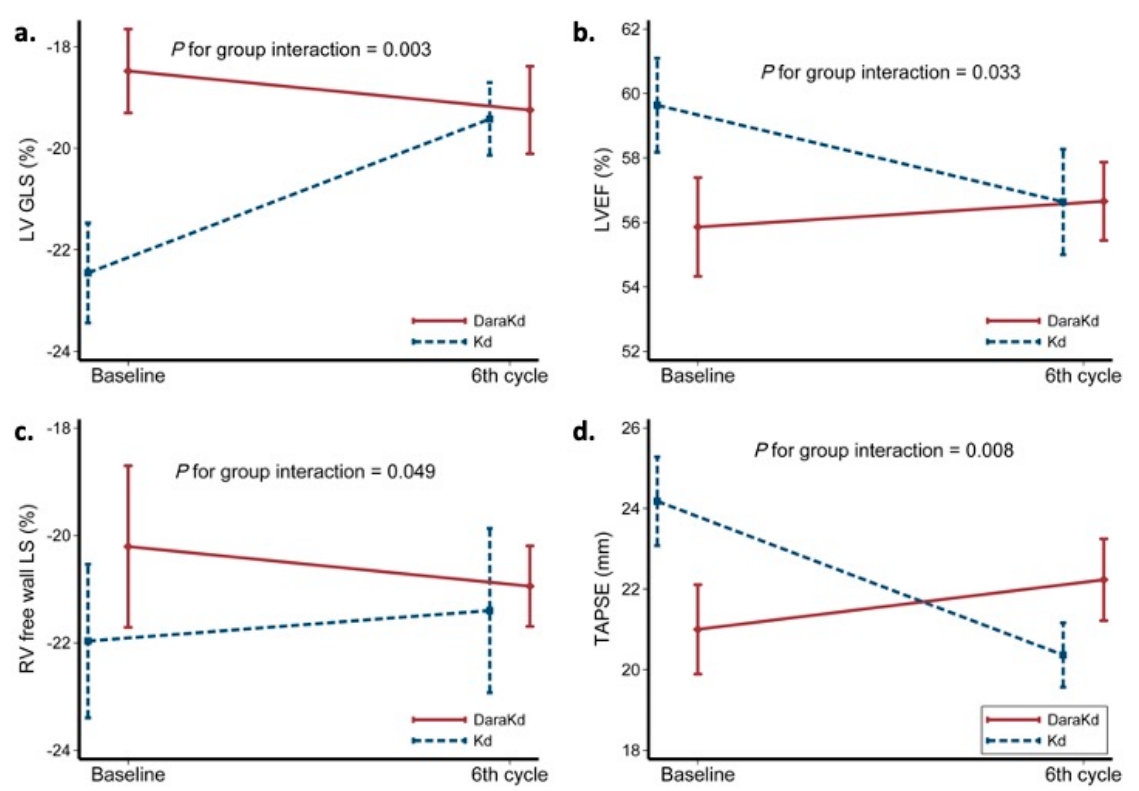
Figure 1. Line diagrams showing changes in LV GLS ( a ), LVEF ( b ), RV free wall strain ( c ) and TAPSE ( d ) and group interaction according to treatment assignment (Kd or DaraKd). p was derived from GLM ANCOVA.